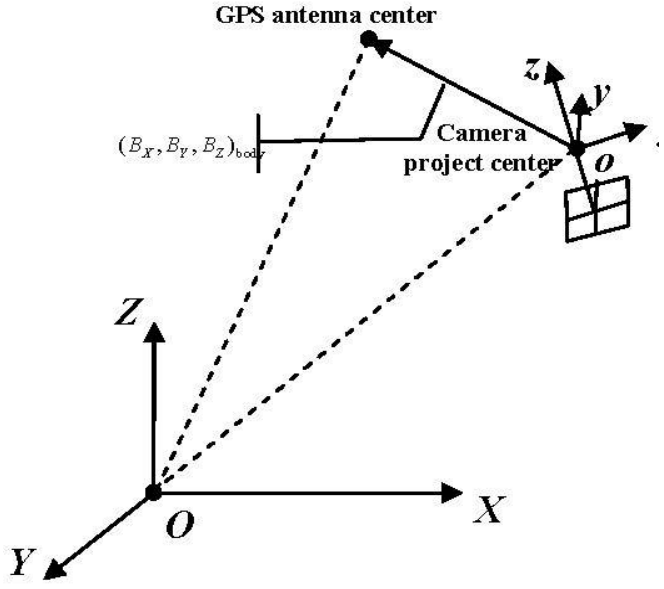
Figure 2. Relationship between GPS antenna center and projection center of